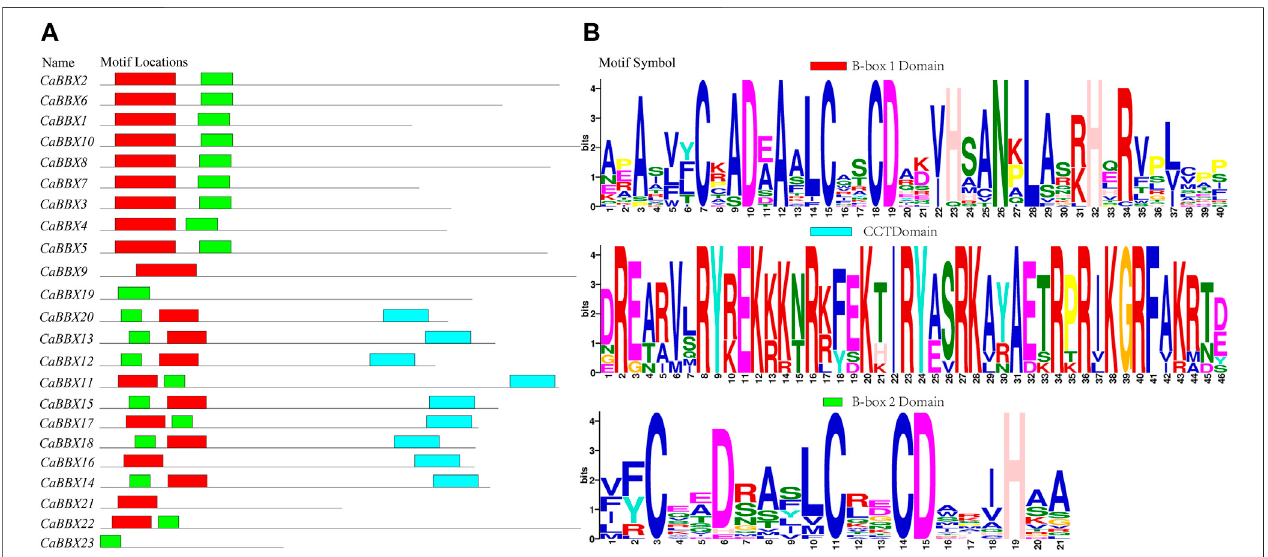
FIGURE 1 | The domains of the CaBBX gene family. (A) The distributions of conserved motifs in CaBBXs . (B) Typical logo of the CaBBX conserved domains.